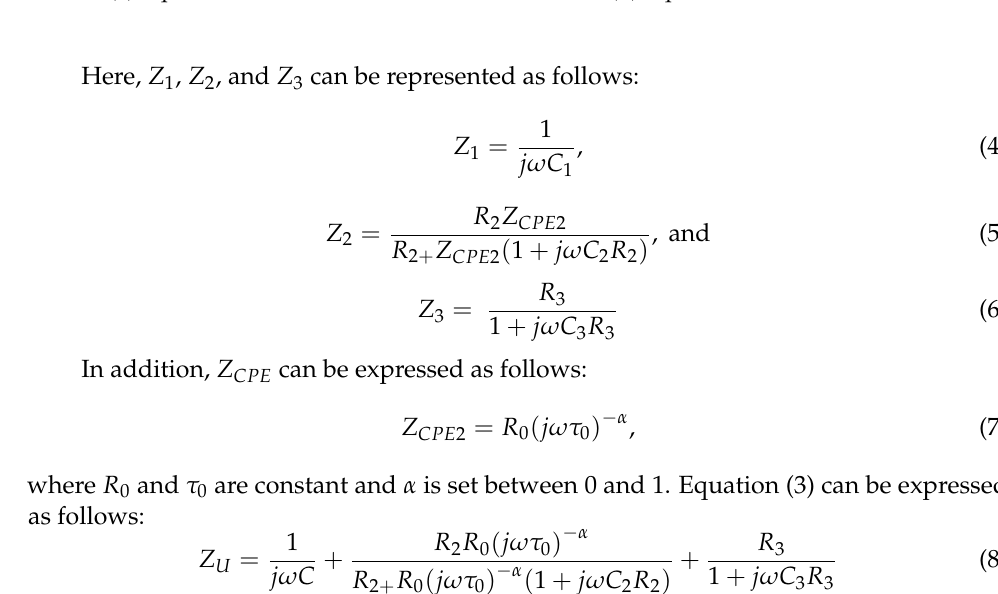
Figure 6. Equivalent circuit model. ( a ) Equivalent circuit model of the unused EDLC. ( b ) Equivalent circuit model of the degraded EDLC.